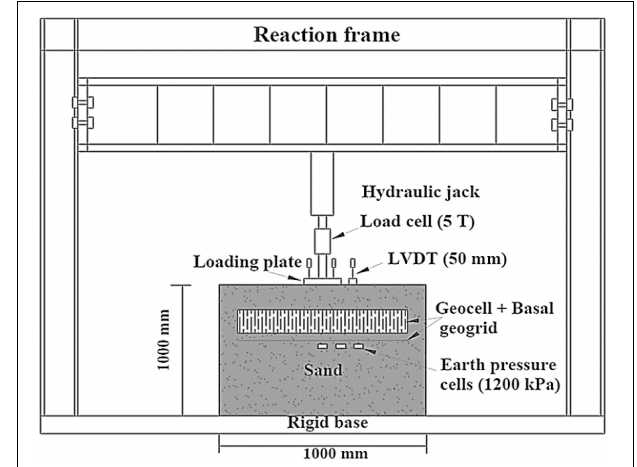
FIGURE 2 | Schematic view of test